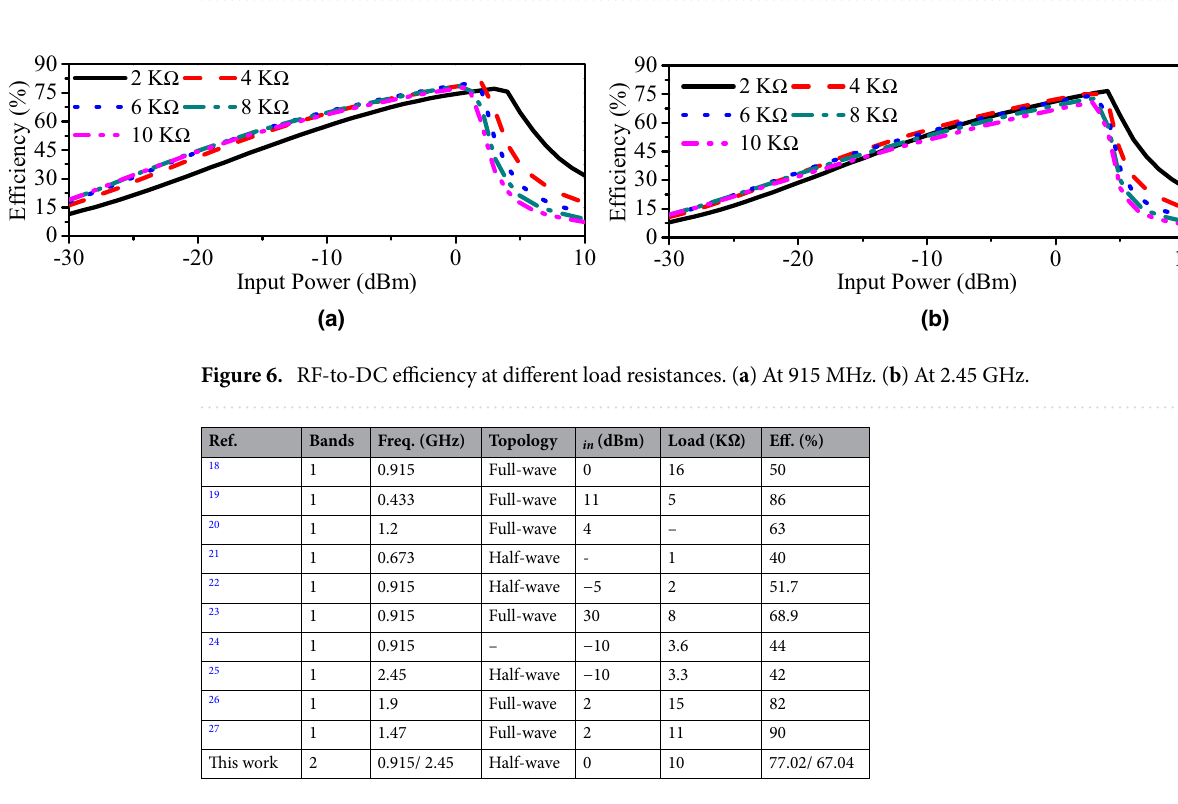
Table 1. Comparison of the proposed rectifier with state-of-the-art implantable rectifiers.